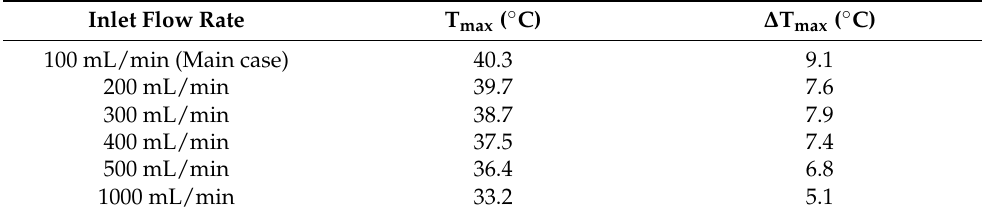
Table 5. The thermal performance of the system with various inlet flow